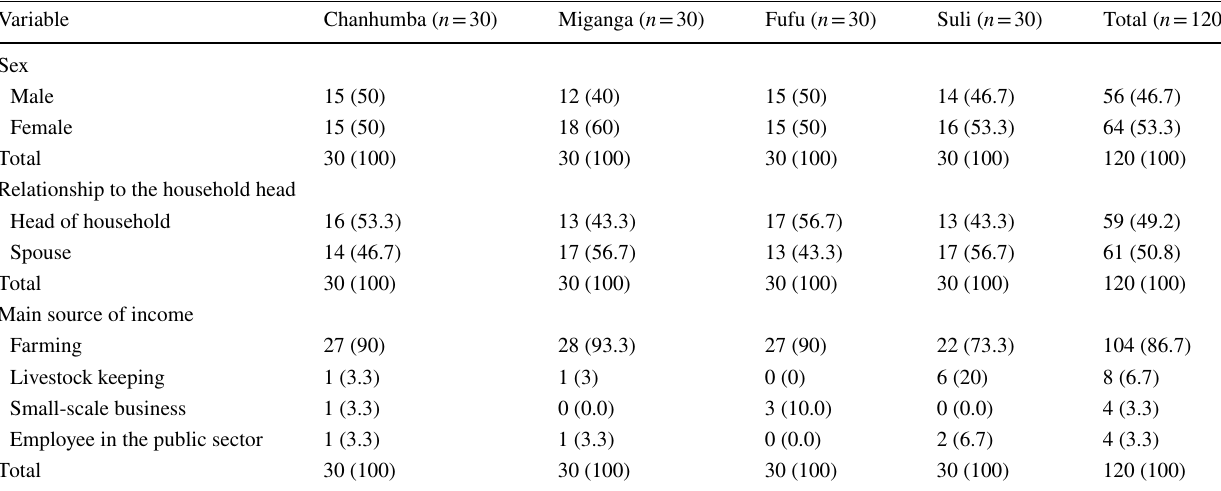
Table 1 Respondents’ socio-economic characteristics ( n =